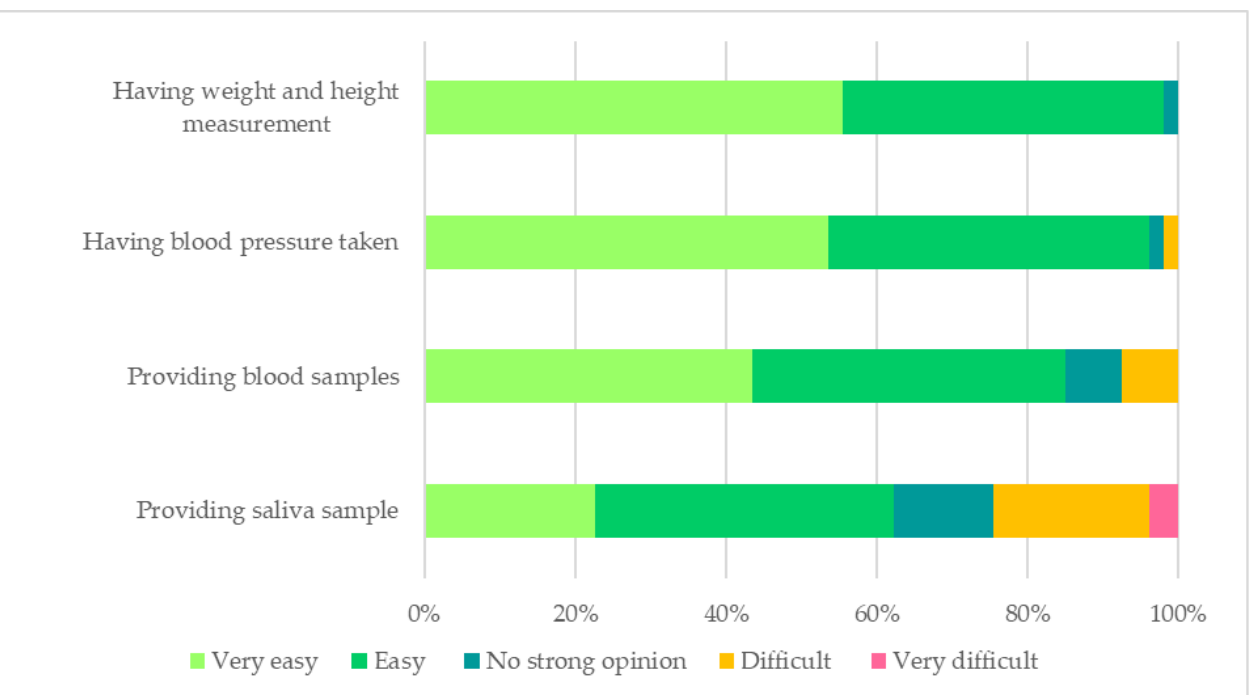
Figure 2. The acceptability of the baseline assessments. Missing information: providing blood samples ( n = 1); providing saliva sample ( n = 1).